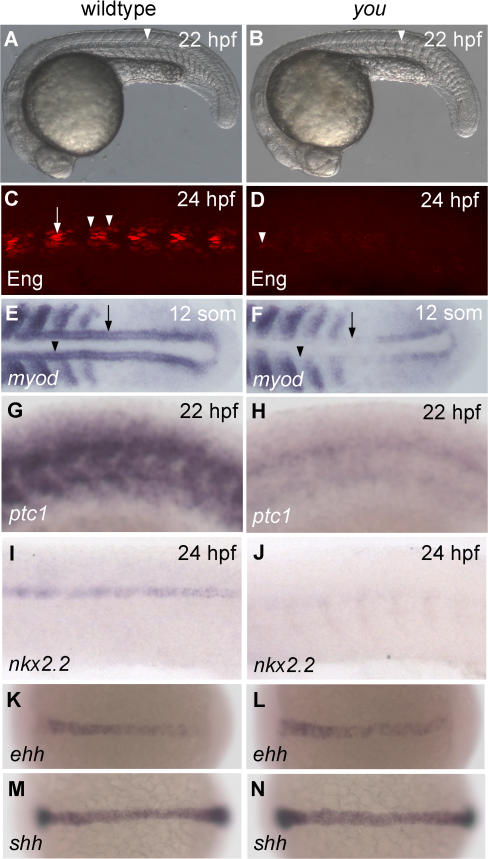

you Mutants Exhibit Hedgehog-Associated Defects in Slow Muscle and Ventral Spinal Cord(A and B) Lateral views of live zebrafish at 22 hpf. Wild-type embryos (A) have chevron-shaped somites and a clearly visible floor plate (arrowhead), while you mutants (B) exhibit U-shaped somites and an indistinct floor plate (arrowhead).(C and D) Lateral views of somites 8–13 in whole-mount embryos at 24 hpf. Wild-type embryos (C) show strong Engrailed expression in muscle pioneers (arrow), and weaker expression in multinucleate medial fast fibers (arrowheads). Engrailed expression in you mutants (D) is mostly absent, though very weak expression can occasionally be observed (arrowhead).(E and F) Dorsal views of posterior trunk and tail bud in 12-somite embryos. Wild-type embryos (E) exhibit adaxial myod expression throughout the somitic (arrowhead) and presomitic (arrow) mesoderm, while you mutants (F) lack expression in the somitic (arrowhead) and in parts of the presomitic (arrow) mesoderm.(G and H) Lateral view of somites 9–15 in whole-mount embryos at 22 hpf. Wild-type embryos (G) exhibit strong expression of ptc1, while you mutants (H) show weaker levels of ptc1 expression.(I and J) Lateral view of spinal cord in the posterior trunk of whole-mount embryos at 24 hpf. Wild-type embryos (I) show expression of nkx2.2 in the ventral spinal cord, while in you mutants (J) this expression is strongly reduced.(K–N) Dorsal views of whole-mount embryos at bud stage (10 hpf). Expression in you mutant embryos of both ehh (L) and shh (N) is similar to that observed wild-type embryos (K and M).Anterior is to the left in all images. Genotypes of all embryos were determined by PCR after photography.